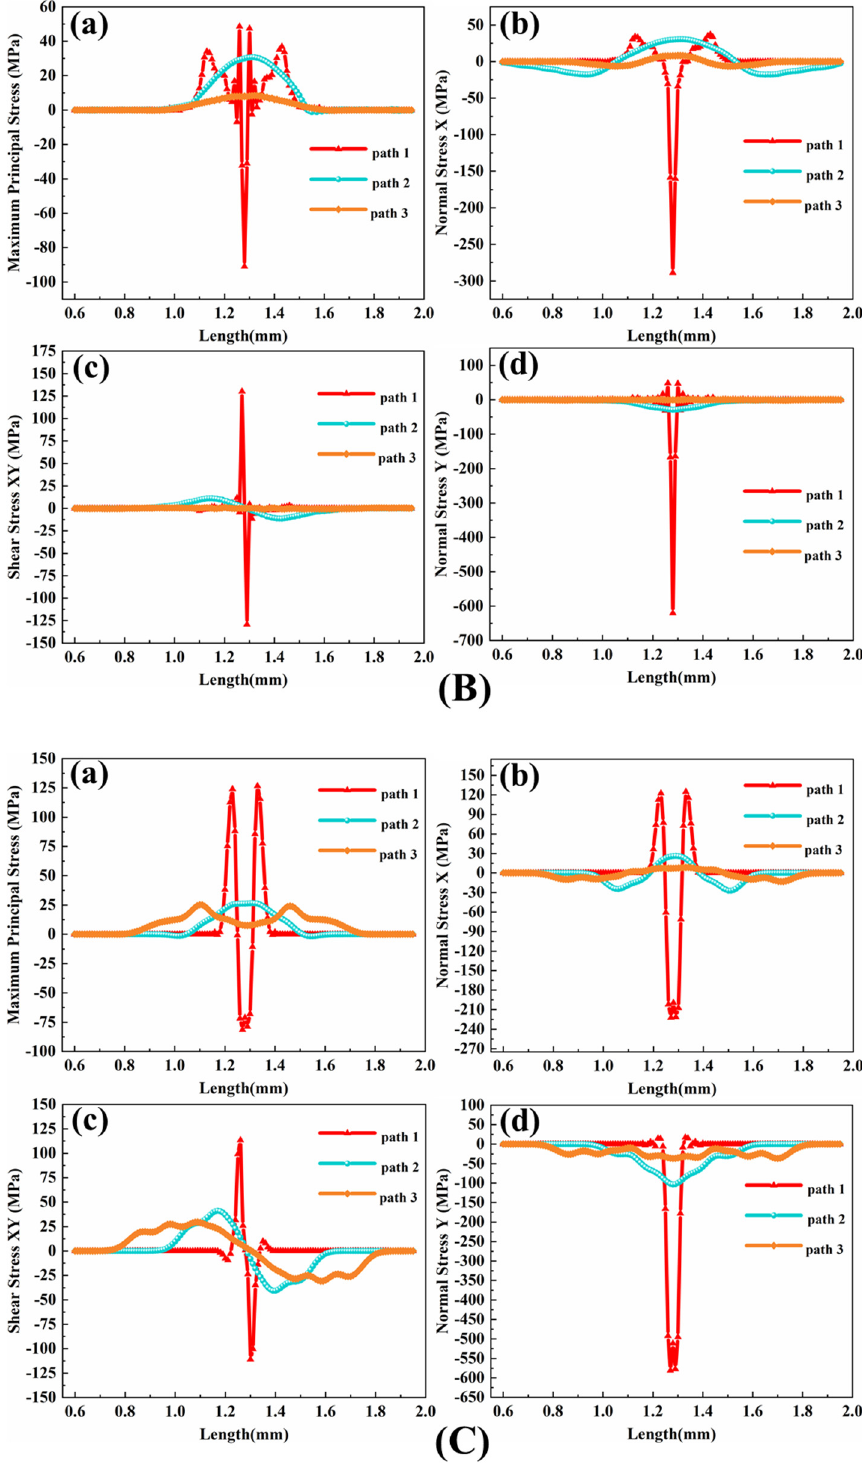
Figure 6. The ( a ) maximum principal stress, ( b ) normal stress X, ( c ) shear stress XY and ( d ) normal stress Y under different contact modes: ( A ) point contact, ( B ) line contact and ( C ) surface contact at the impact velocity equal to 100 m/s and the impact angle equal to 90°.